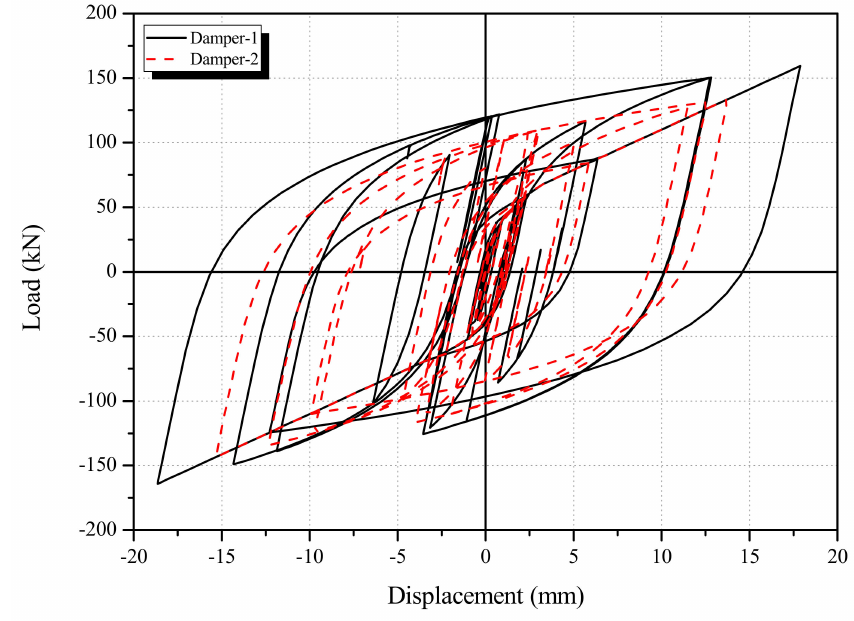
Figure 31. Seismic response load–displacement relationship of